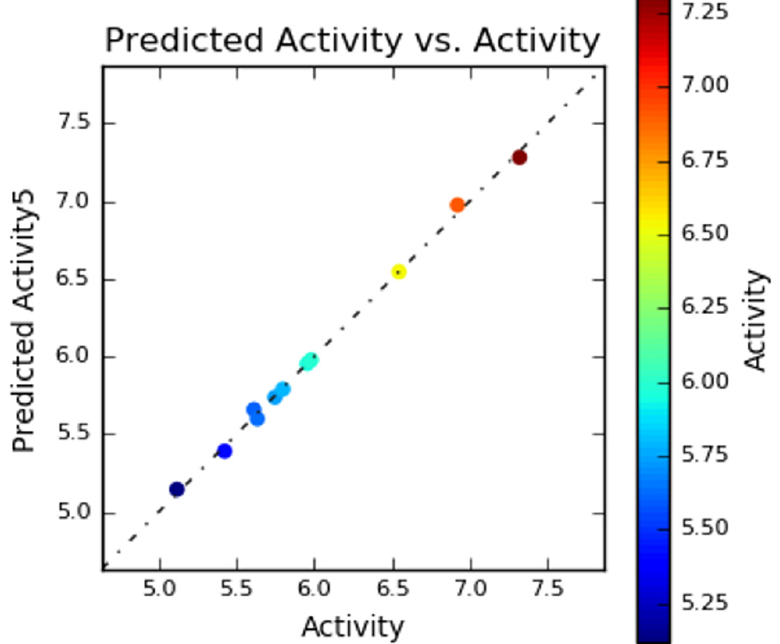
Figure 2. Correlation analysis of predicted PIC 50 values by QSAR model and experimental PIC 50